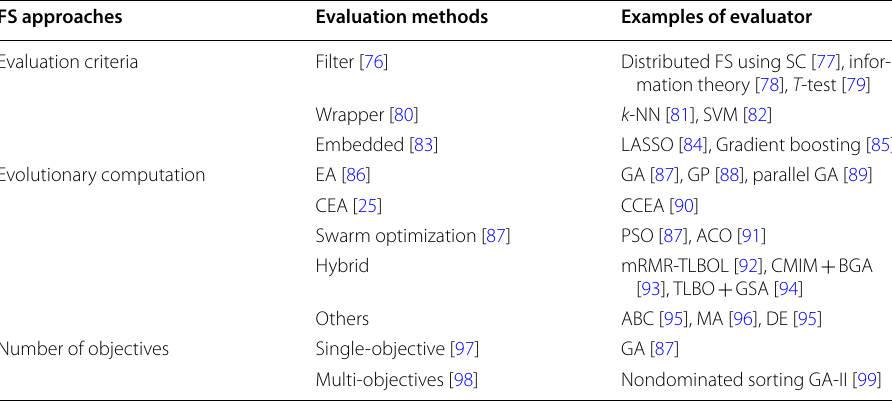
Table 1 Taxonomy of FS approaches [5, 74,